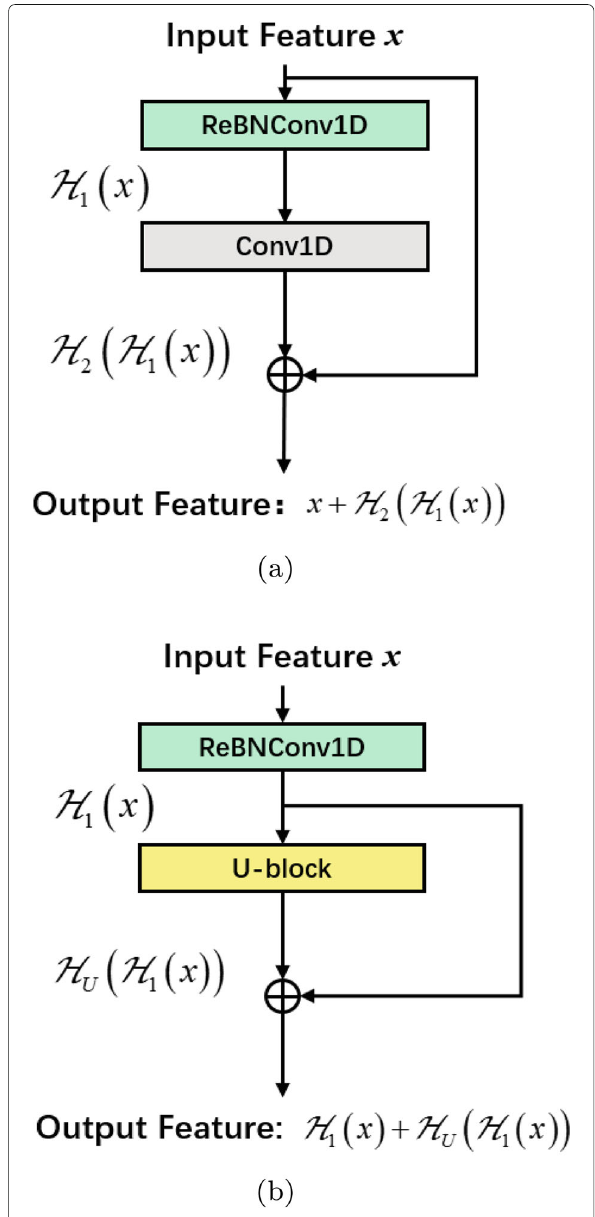
Fig. 3 The comparison of 1-2-1 residual U-block and plain residual block. a The residual block. b The 1-2-1 residual U-block (1-2-1RSU). The constitution of the output feature from each block illustrates why the 1-2-1 residual U-block can preserve more details than plain residual